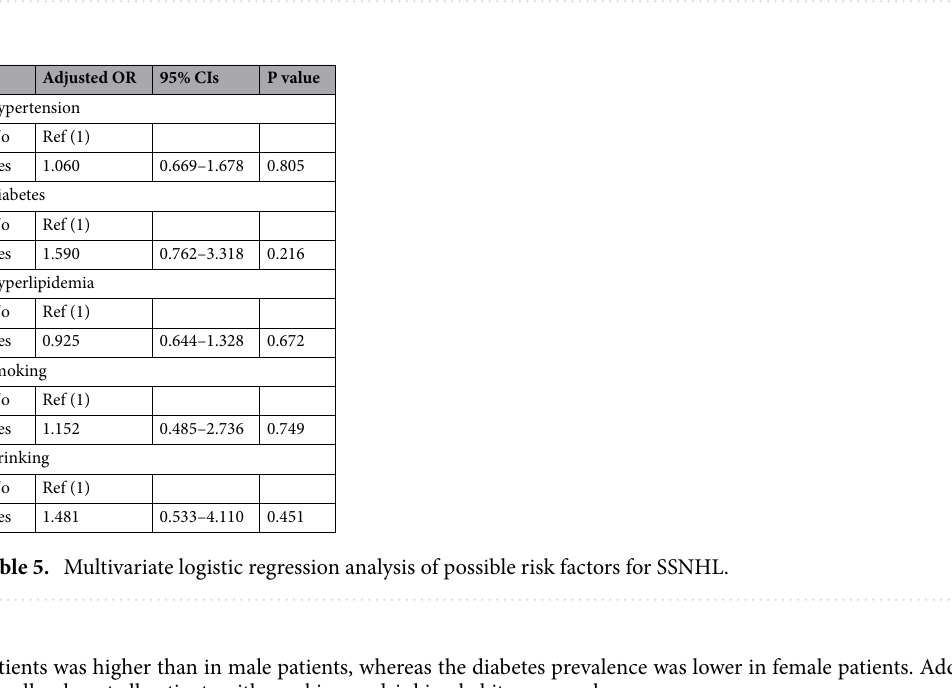
Table 4. Univariate logistic regression analysis of possible risk factors for SSNHL.